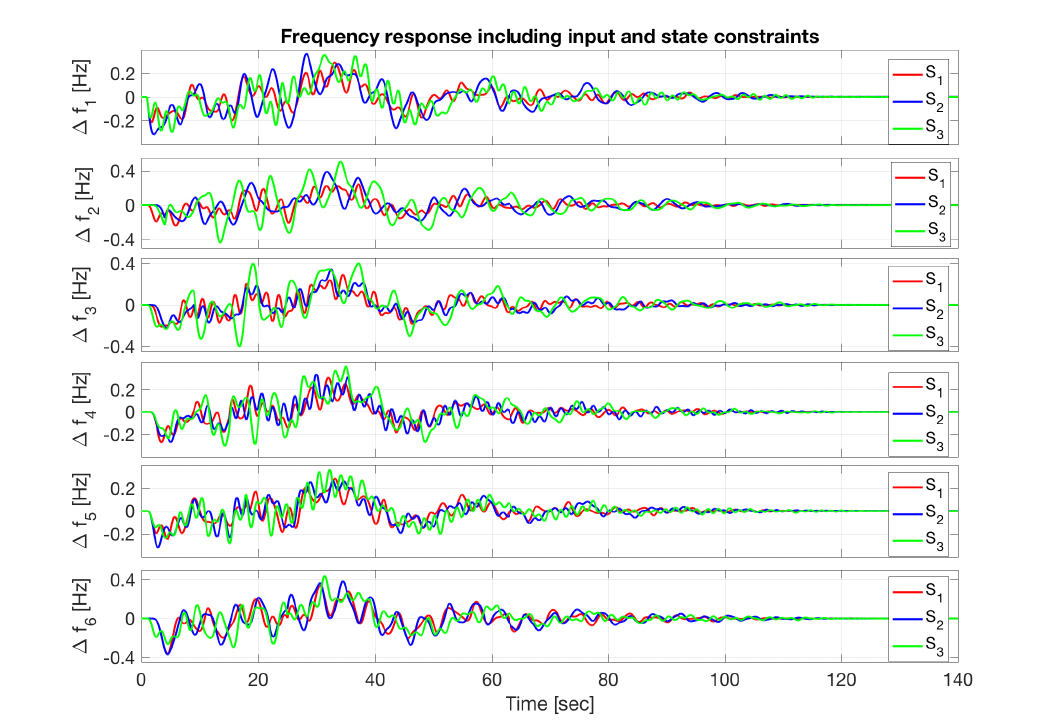
Figure 18. Frequency transients of the six-area power system for three tie-line interconnection schemes ( S ) . Input and state constraints are included in the model of each area (Figure 17). Selection of 1 , S 2 , S 3 weighting matrices according to Bryson’s